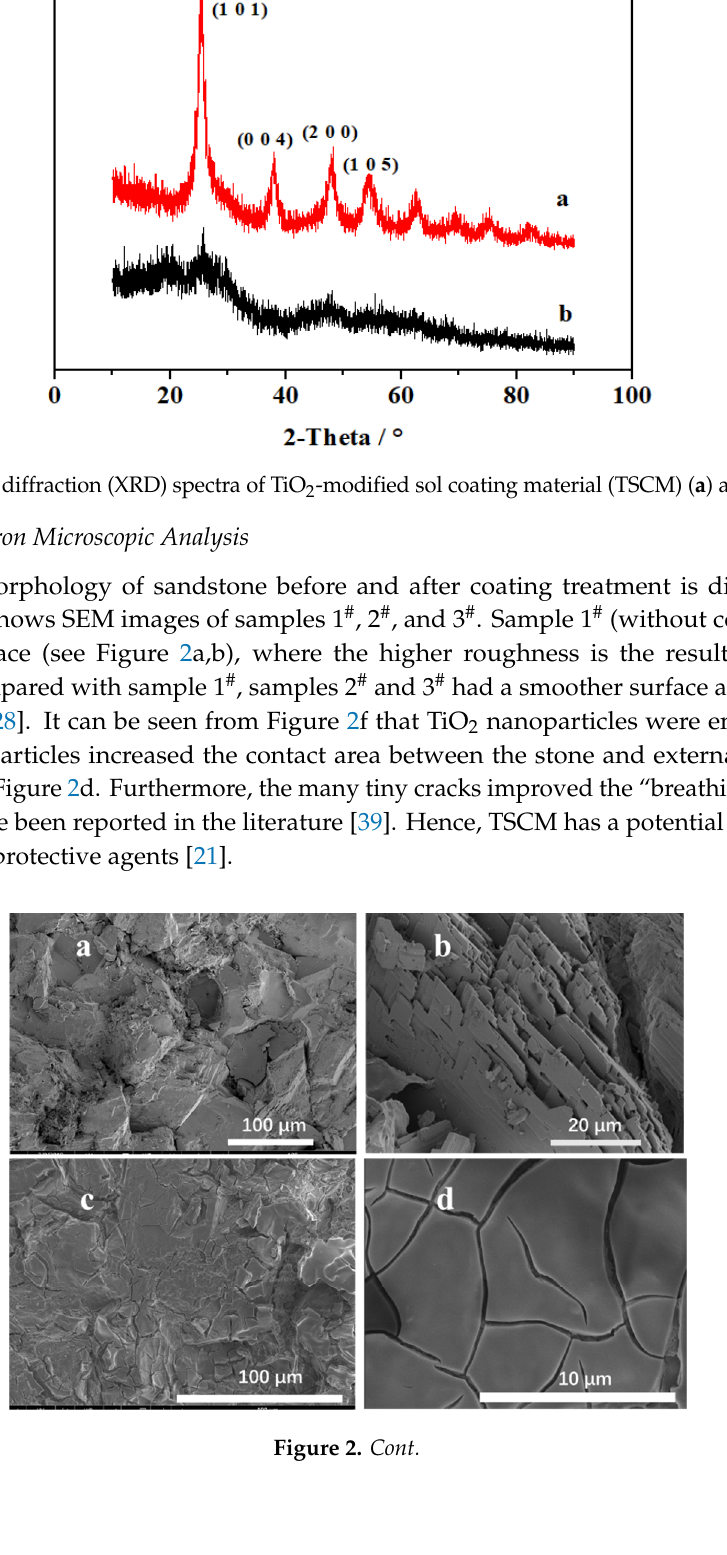
Figure 2. Scanning electron microscopy (SEM) images of sample 1 # ( a ) 100 um, ( b ) 20 um; sample 2 # ( c ) 100 um, ( d ) 10 um; and sample 3 # ( e ) 100 um, ( f ) 10 um. 3.4. Water Absorption Water absorption is an important parameter in evaluating protective performance. Figure 3 presents the relationship between water absorption and the number of cycles. With an increasing number of cycles, water absorption increased sharply, and then decreased slowly. The water absorption in the different samples was almost equal when the number of cycles was greater than 5. Because the stone begins to absorb water quickly, the water absorption increases. When the water absorption is close to saturation, the water absorption rate decreases. The water absorption of sample 1 # was the largest, while that of sample 3 # was the smallest [40], indicating that the TSCM has made the sandstone samples more compact and less permeable to water. Low water absorption can protect the samples against the erosion of water and a soluble salt or base. Figure 3. Water absorption curves. -2 Sample 1 # Sample 2 # Sample 3 #